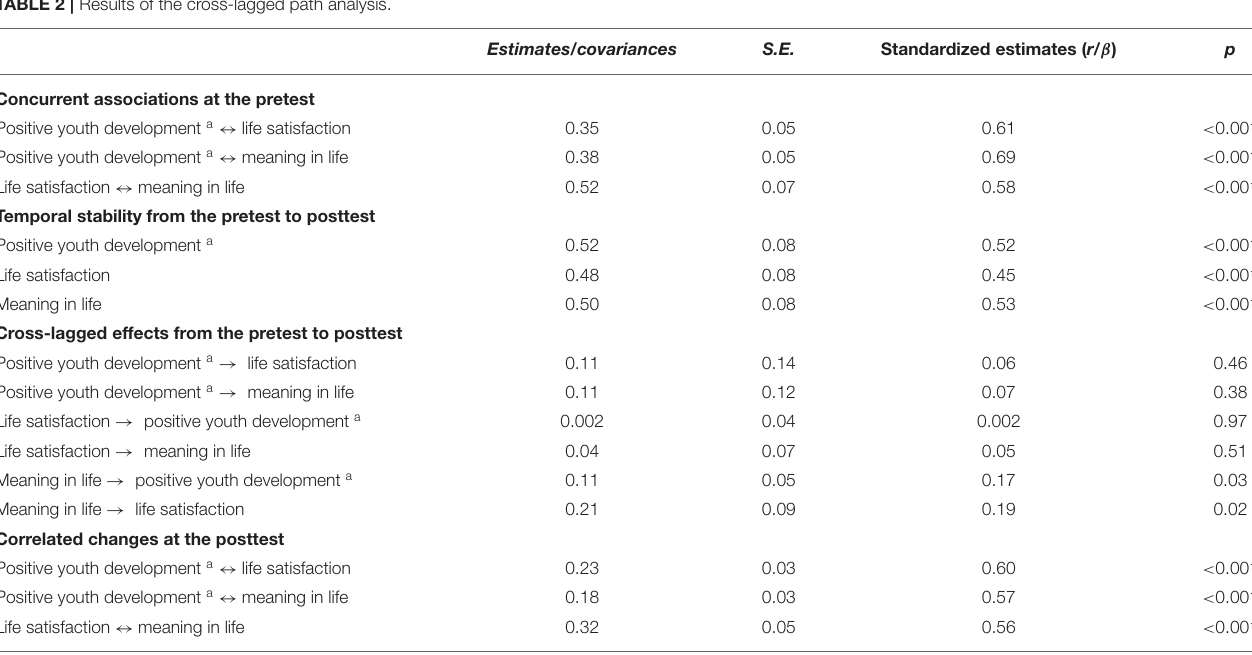
TABLE 2 | Results of the cross-lagged path